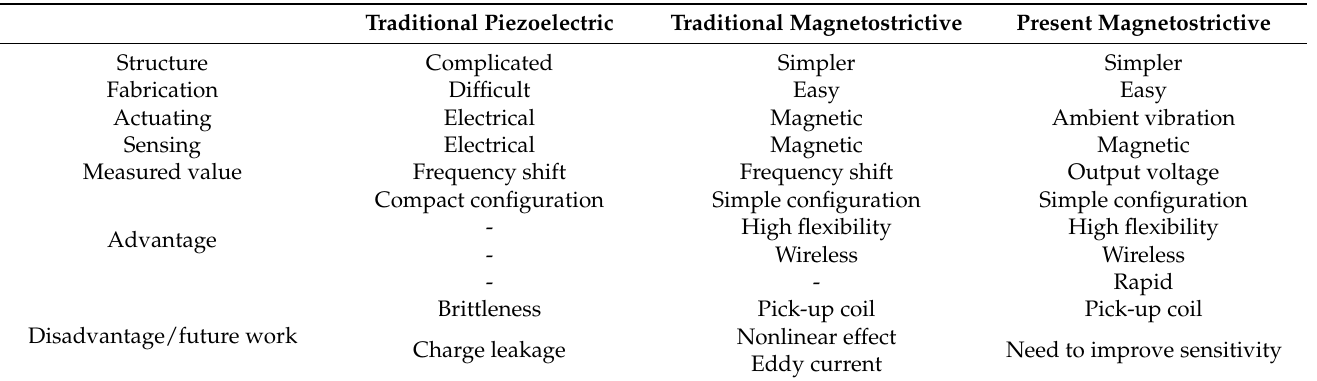
Figure 8. Schematic of ( a ) magnetostrictive harvester, ( b ) voltage to frequency during detection, and ( c ) bio-interfacial interaction of spike glycoprotein with mixed SAMs. Table 5. Comparison of different biosensors.